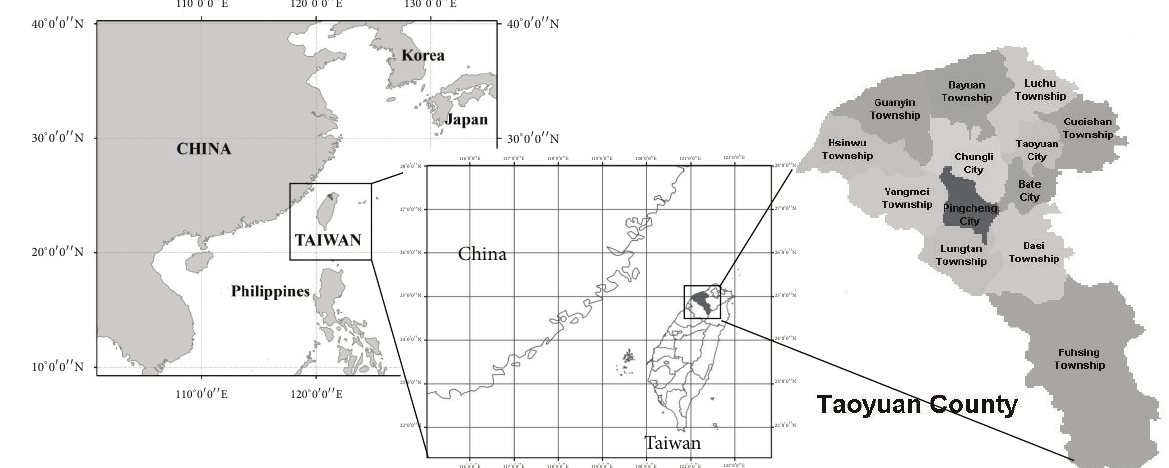
Figure 1: Geographic location of Taoyuan County, Taiwan.